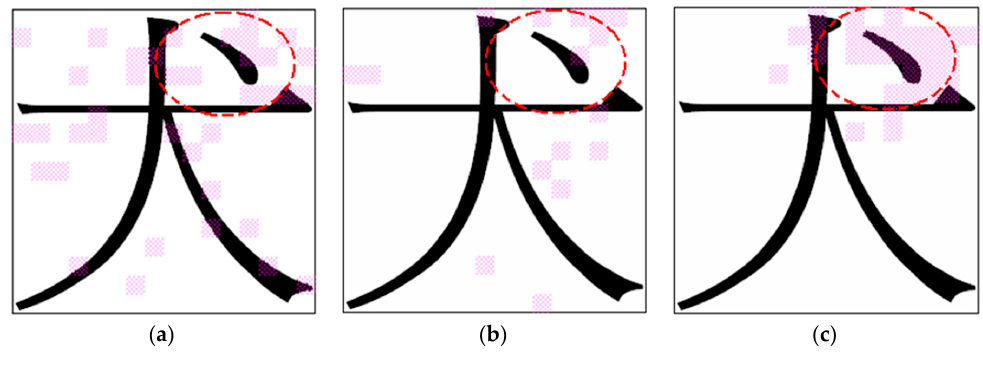
Figure 13. Feature vectors selected by ( a ) IG; ( b ) SFFS; ( c ) NRFS. Table 8. Experimental results of noisy data set of Chinese characters.